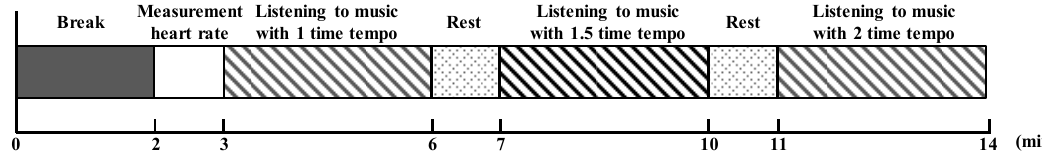
Figure 10. Experimental flow about relationship between heart rate and tempo of music. Figure 9. Arrangement of speakers and attached brain wave meter. Figure 9. Arrangement of speakers and attached brain wave meter. Appl. Sci. 2020 , 10 , x FOR PEER REVIEW